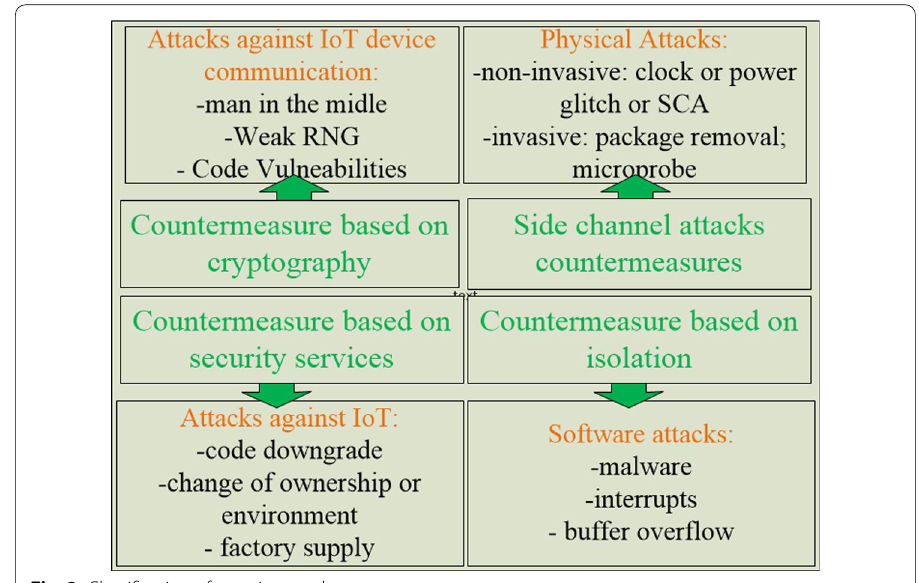
Fig. 2 Classification of security